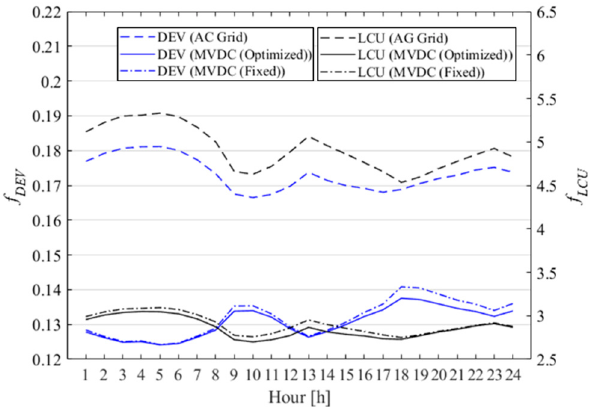
Figure 9. Comparison of two objective functions in Area 1.